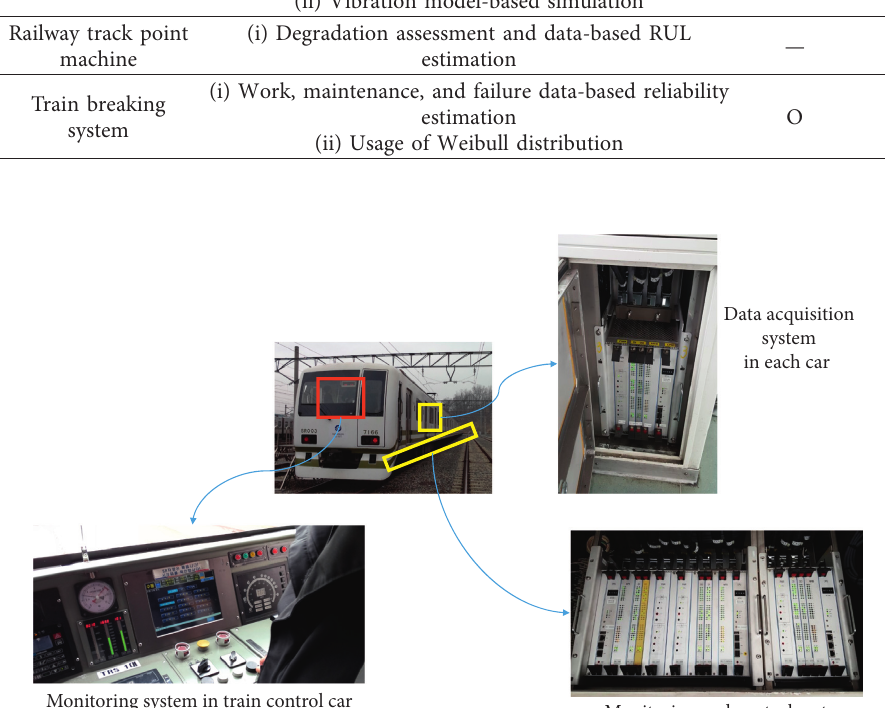
Figure 1: Train control and monitoring system (TCMS) in Korean trains and cars. (a) Monitoring system in train control car. (b) Monitoring and control system in train driving modules. (c) Data acquisition system in each Table 3 summaries the TCMS data used in this study and the general specifications of the proposed RUL prediction framework.